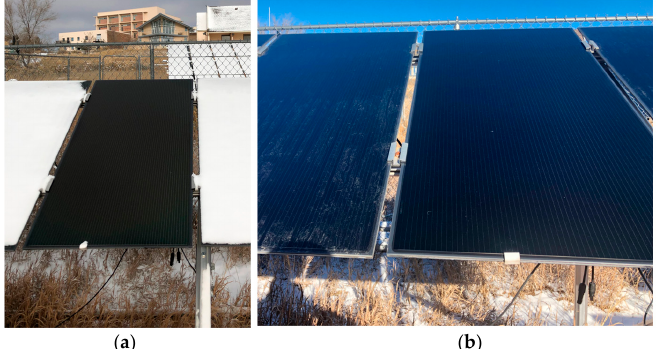
Figure 1. ( a ) A comparison of modules coated and uncoated and exposed to snowfall in Colorado. Snow did not accumulate on the black thin film CdTe panel with a hydrophobic coating. This panel continued to produce power after snowfall. All other panels were covered in snow; ( b ) following the snowmelt, residues were deposited on the uncoated panel ( left ), while the coated panel ( right ) remained clean. The anti-soiling e ff ect gradually degraded over a few weeks